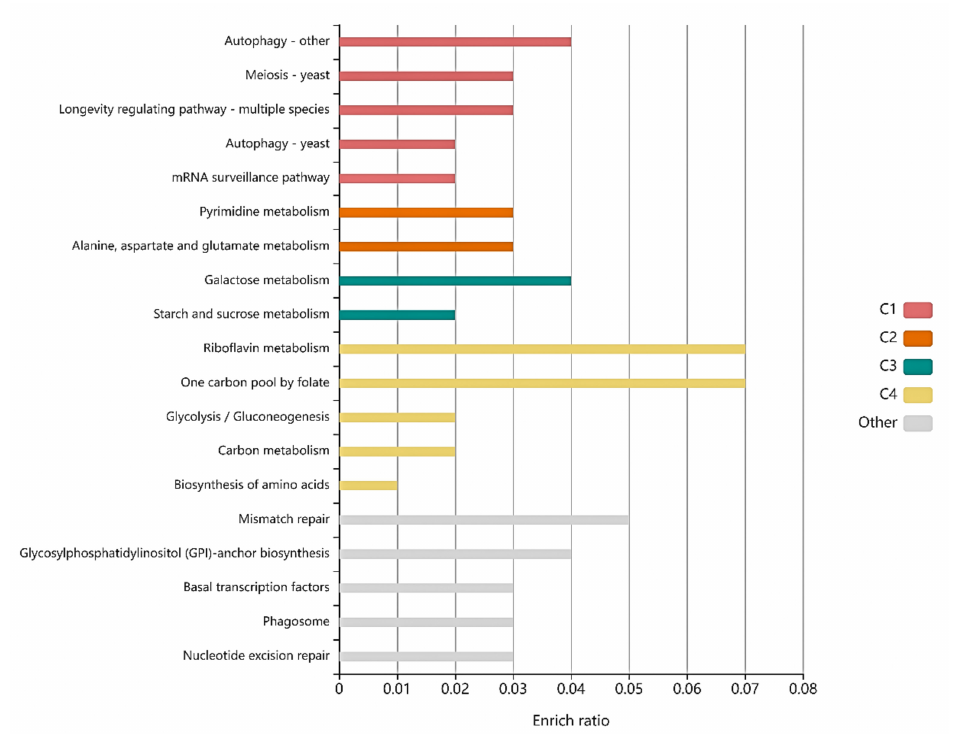
Figure 3. Histogram presentation of genes mapped to the KEGG database. The horizontal coordinates represent the pathway name, and the vertical coordinates represents the rich factor. The color of the bar (C1, C2, C3, C4, Other) represents different clusters. For each cluster, if there are more than 5 terms, top 5 with the highest enrich ratio will be